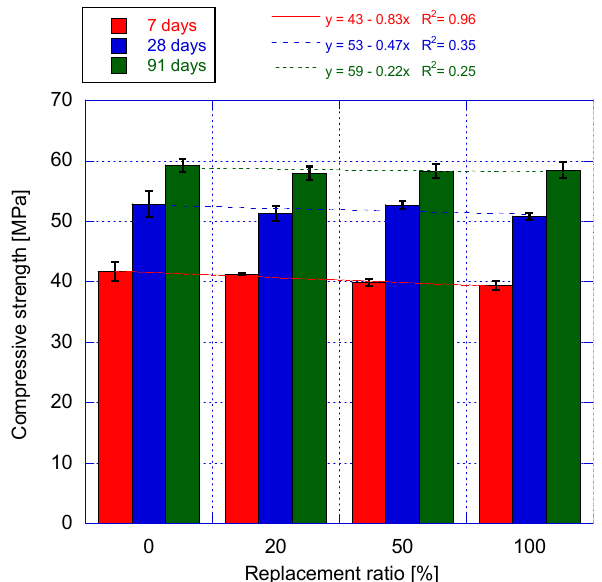
Figure 4. Compressive strength of all mixes at different ages.